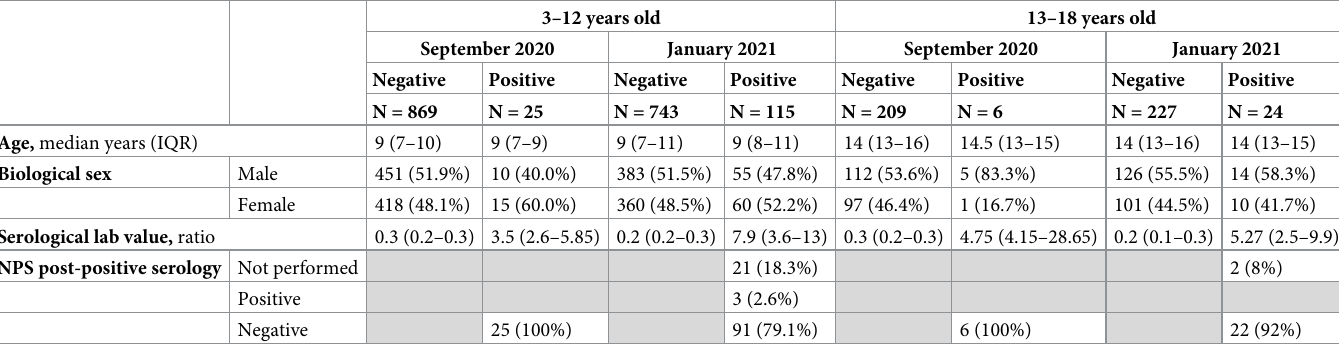
Table 2. Characteristics of pupils who attended in presence and who switched to remote